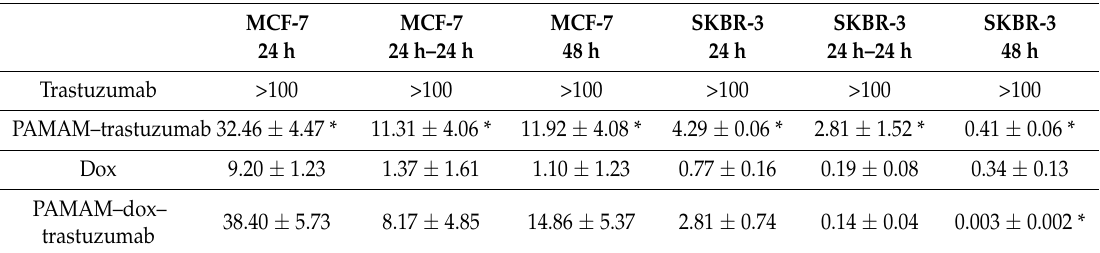
Table 1. Comparison of IC 50 value for trastuzumab, doxorubicin, PAMAM–trastuzumab and PAMAM–dox–trastuzumab conjugates in two breast cancer cell lines. The IC 50 values are presented as mean ± S.D. of three